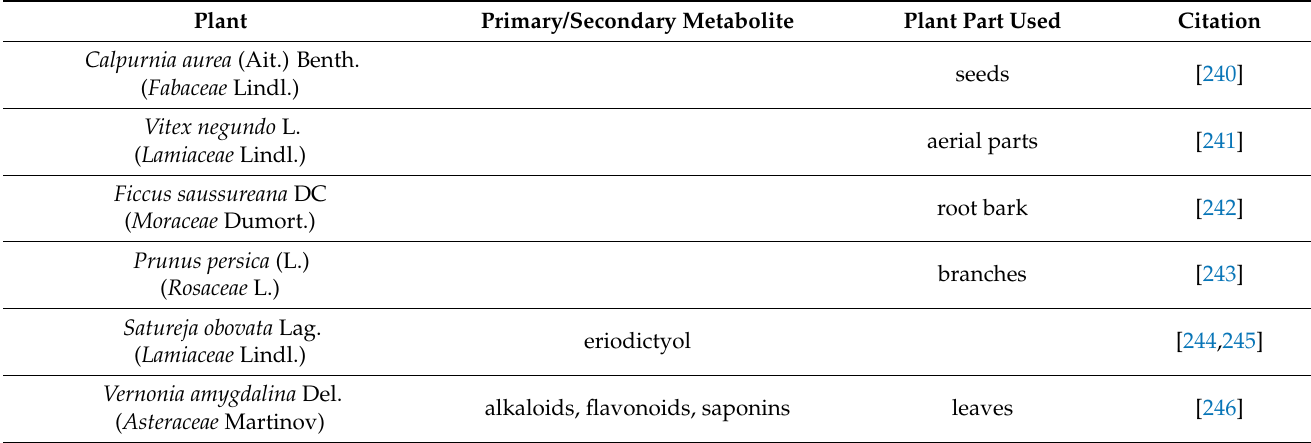
Table 6. Not fully elucidated/not